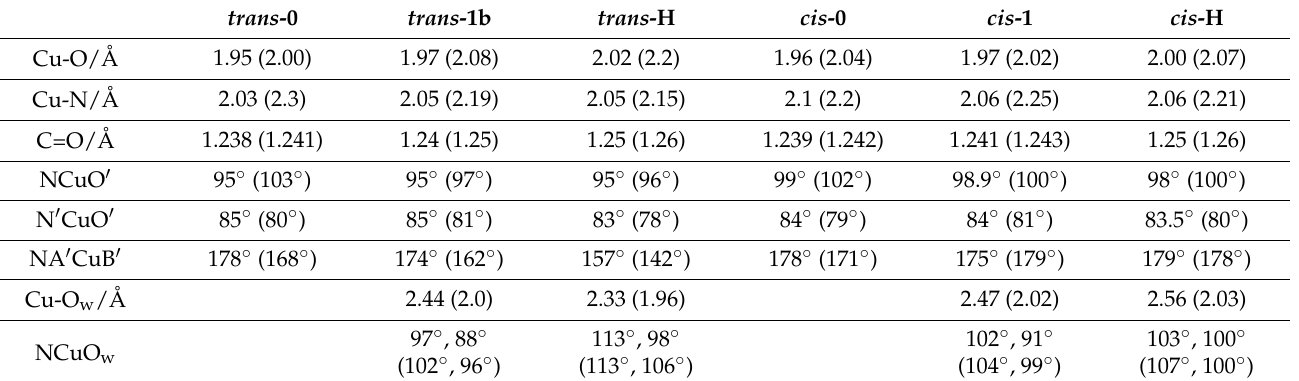
Table 1. Calculated structural properties of the Cu(L-proline) 2 complexes in the ground electronic state (see Figure 2 for graphical representations of the complexes). In brackets we report the values obtained from the optimization of the first excited electronic state. The presence/absence of the prime on the atomic symbols denotes atoms belonging to different prolines. In the definition of the dihedral angle, A and B represent the Cu 2+ coordinating O (cid:48) and N (cid:48) atoms of the trans geometry systems, and, correspondingly, the Cu coordinating N (cid:48) and O (cid:48) atoms of the cis geometry systems. O w represents the oxygen atom of the coordinating water